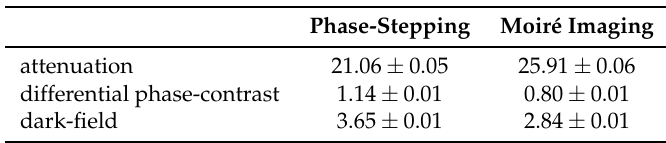
Table 3. Contrast to noise ratios of the three image modalities for both imaging methods. All images are acquired with a dose of 900mAs at a peak voltage of 40kVp.